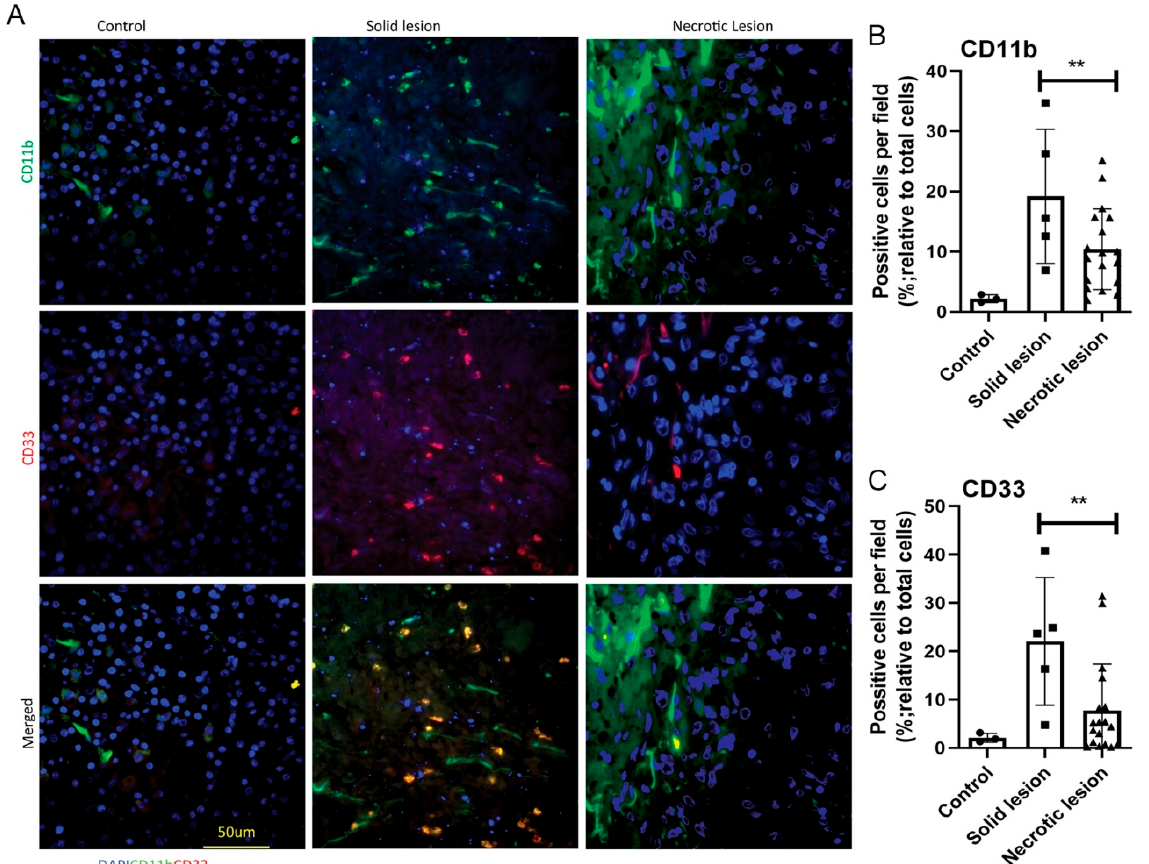
Figure 1. Multiplex immunostaining and imaging of human granulomas with MDSCs markers. ( A ) Representative images showing the of expression of MDSC markers CD11b (green spots) and CD33 (red spots) as well as their co-localization (brown spots) in lung tissues corresponding to control, solid/solid/non-necrotic and necrotic granulomas. Host cell nucleus is stained blue with DAPI. Scale bar in “Merged” panel (50 microns) is common for all the images. ( B ) Proportion of cells positive for CD11b relative to the total number of cells in the field in control, solid/solid/non-necrotic granulomas and necrotic granulomas. ( C ) Proportion of cells positive for CD33 in control, solid/solid/non-necrotic granulomas and necrotic granulomas. Data plotted in ( B , C ) are mean and standard error mean (SEM) of n = 3 (control); n = 5 (solid lesion) and n = 18 (necrotic lesion). Data were analyzed by One-way ANOVA with Tukey’s post-hoc correction for multiple group comparison; ** p <